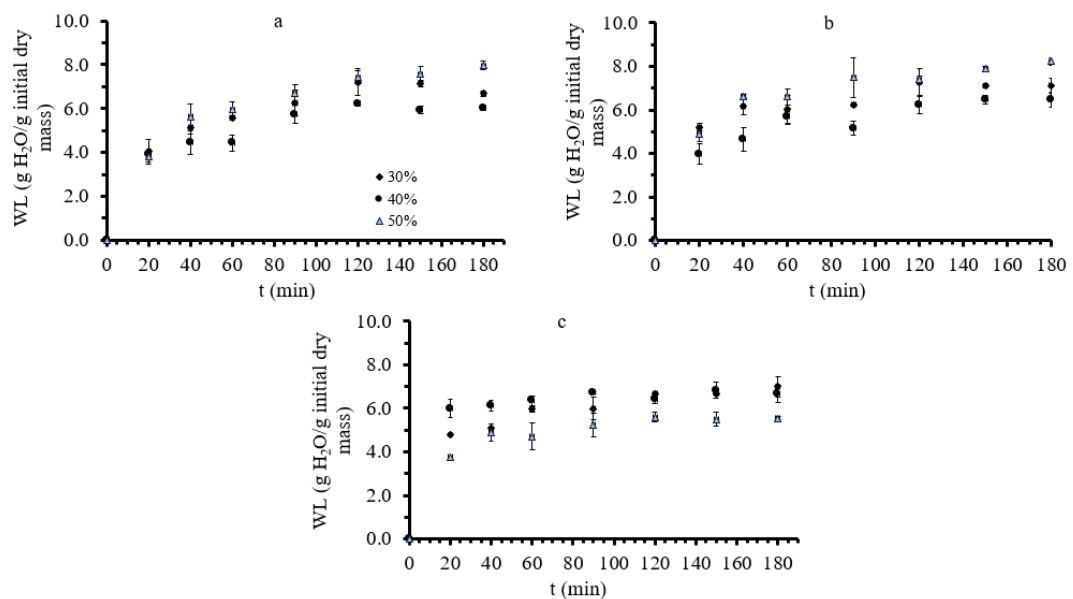
Figure 2. ( a – c ): Water loss (WL, g water/g initial dry mass) during osmotic dehydration at 30, 40, and 50 °C, respectively, at all three different glycerol concentrations. Points represent average values, and error bars represent the standard deviation, as calculated from the three measurements.